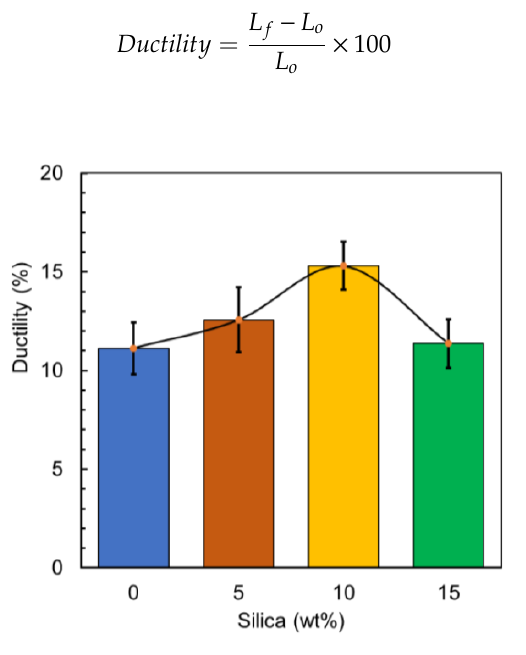
Figure 13. Ductility of the prepared material.